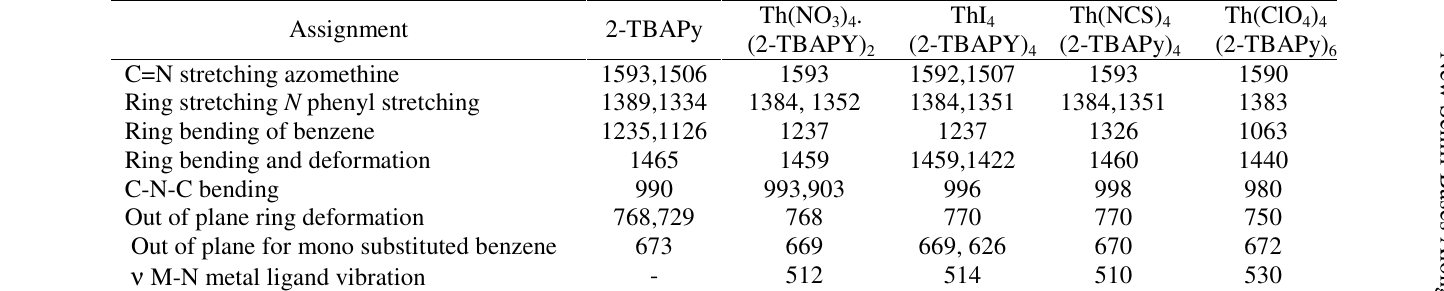
Table 5. Infra red absorpton frequencies (cm -1 ) for dioxouranium(VI) complexes of 2-TBAPy.